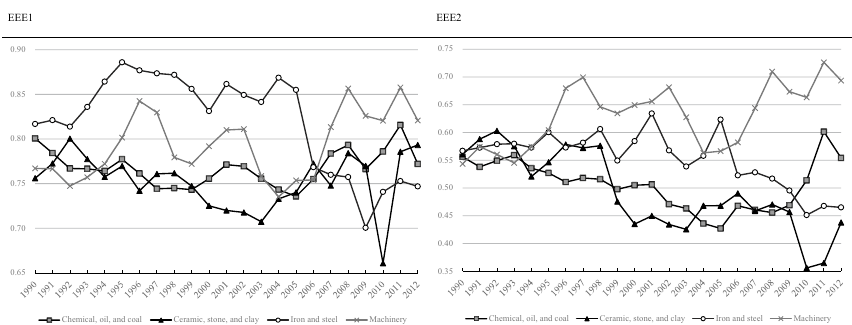
Fig. 3 Changes in EEE1 and EEE2 by heavy industry (1990–2012). The values in the figure are the arithmetic mean of each industry based on the measurement results by